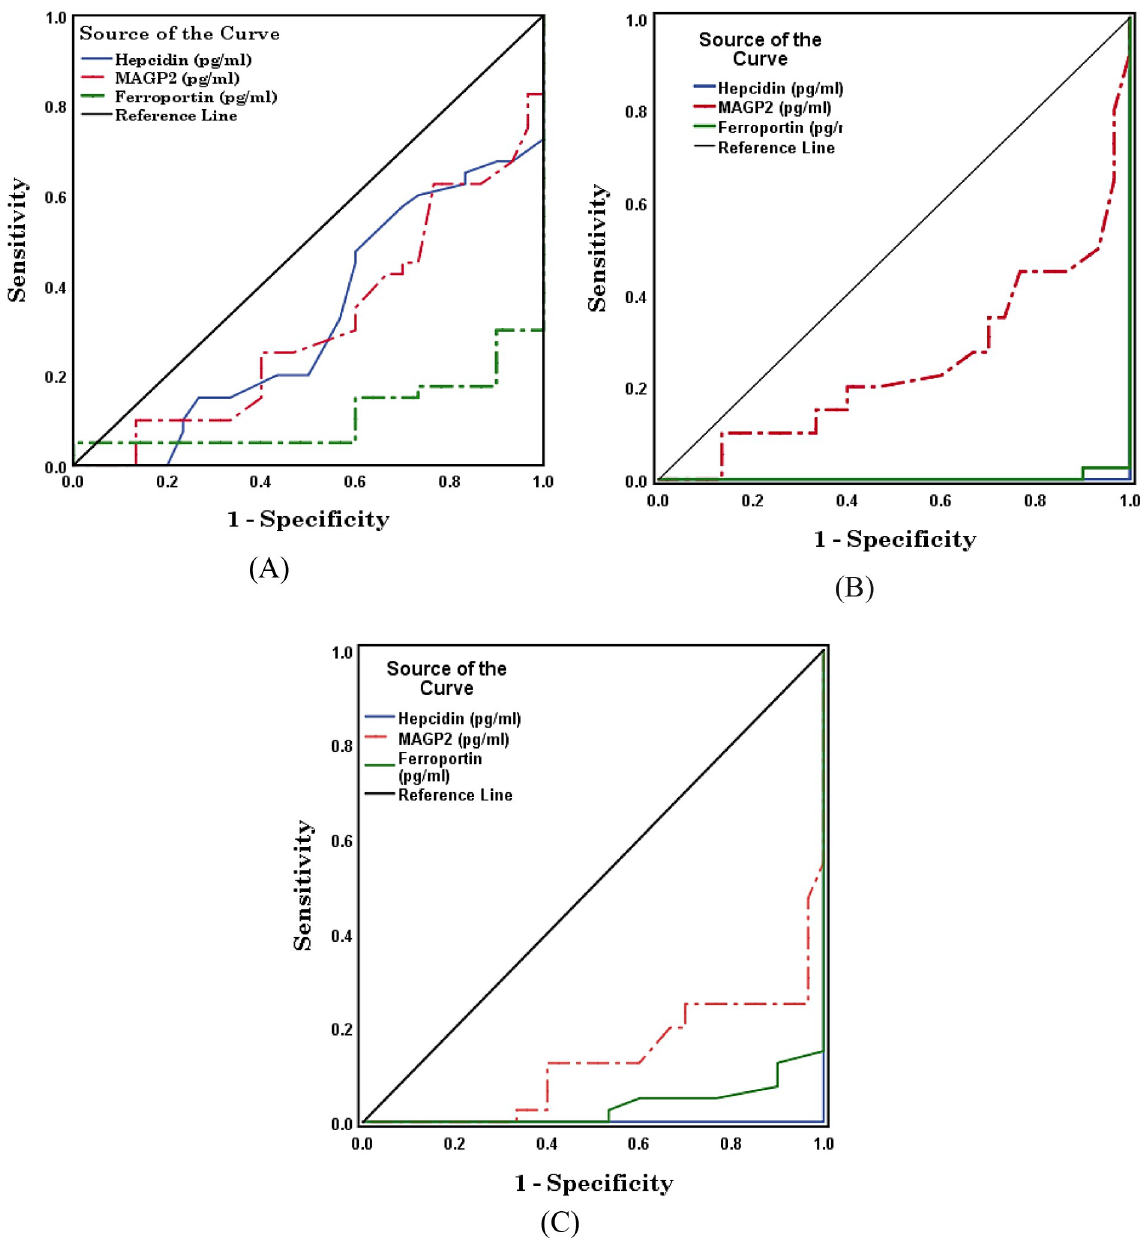
Fig 4. Receiver operating characteristic (ROC) curves displaying the accuracy of hepcidin (pg/ml), MAGP2 (pg/ml), and ferroportin (pg/ml) in benign ovarian tumor (A), early ovarian cancer (B), and late ovarian cancer (C).